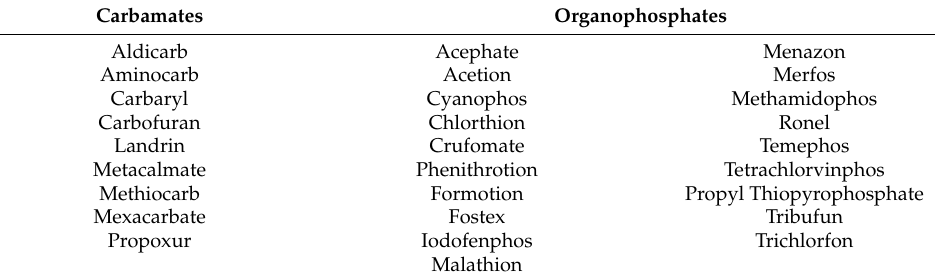
Table 1. Commercially available carbamates and organophosphates, adapted from